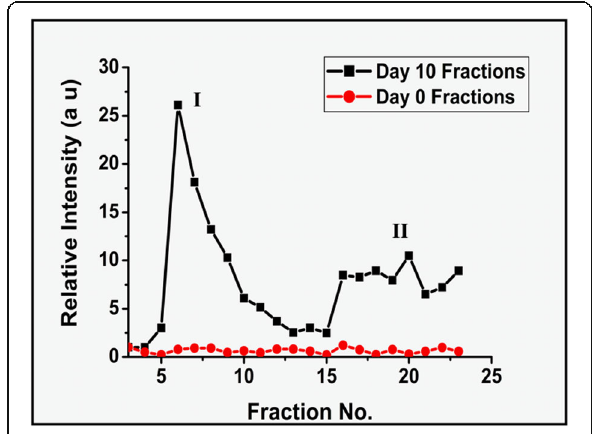
Fig. 4 Comparison of AGE fluorescence in day 0 Fruc-Hb and day 10 Fruc-Hb fractions expressed as the intensity of fluorescence emission at 450 nm